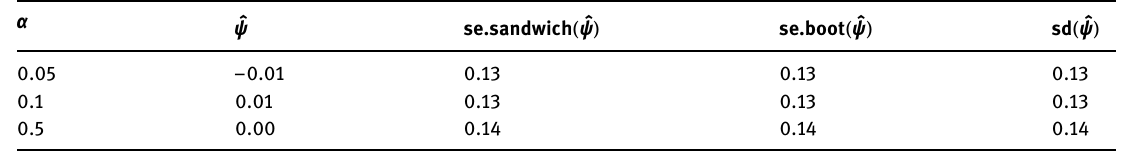
Table 3: Simulation results when using the true value of α in the estimation of ψ . Mean estimate ψ ˆ together with its mean sandwich standard error, mean bootstrap standard error, and its empirical standard deviation